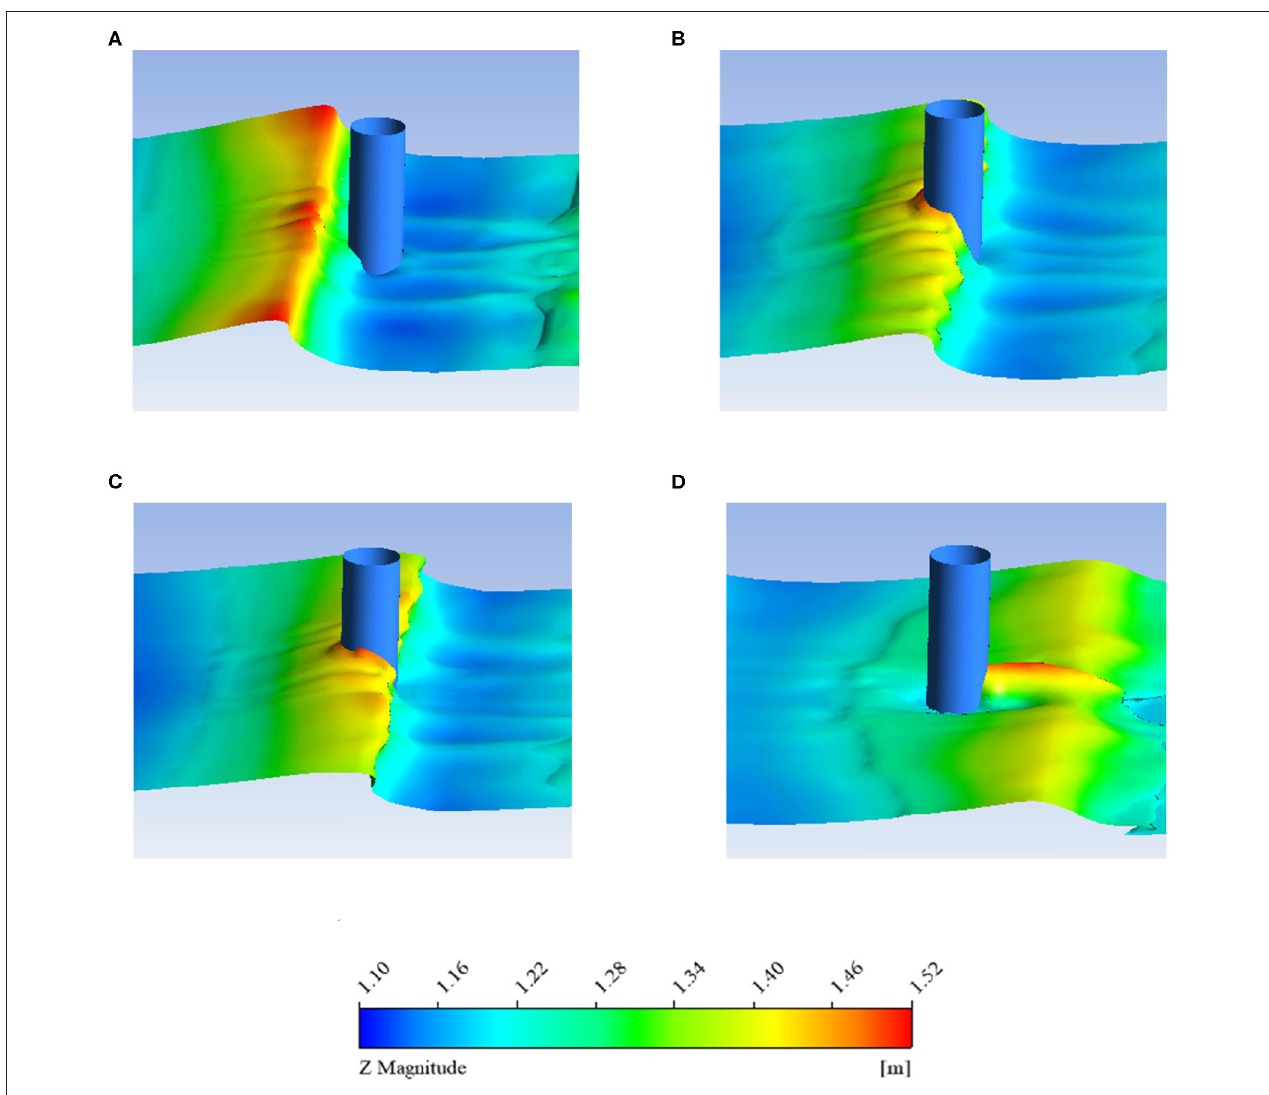
FIGURE 11 | Breaking wave ( ξ 0 = 0.594) flow around the monopile foundation. (A) time = 10.68s; (B) time = 11s; (C) time = 11.08s; (D) time =